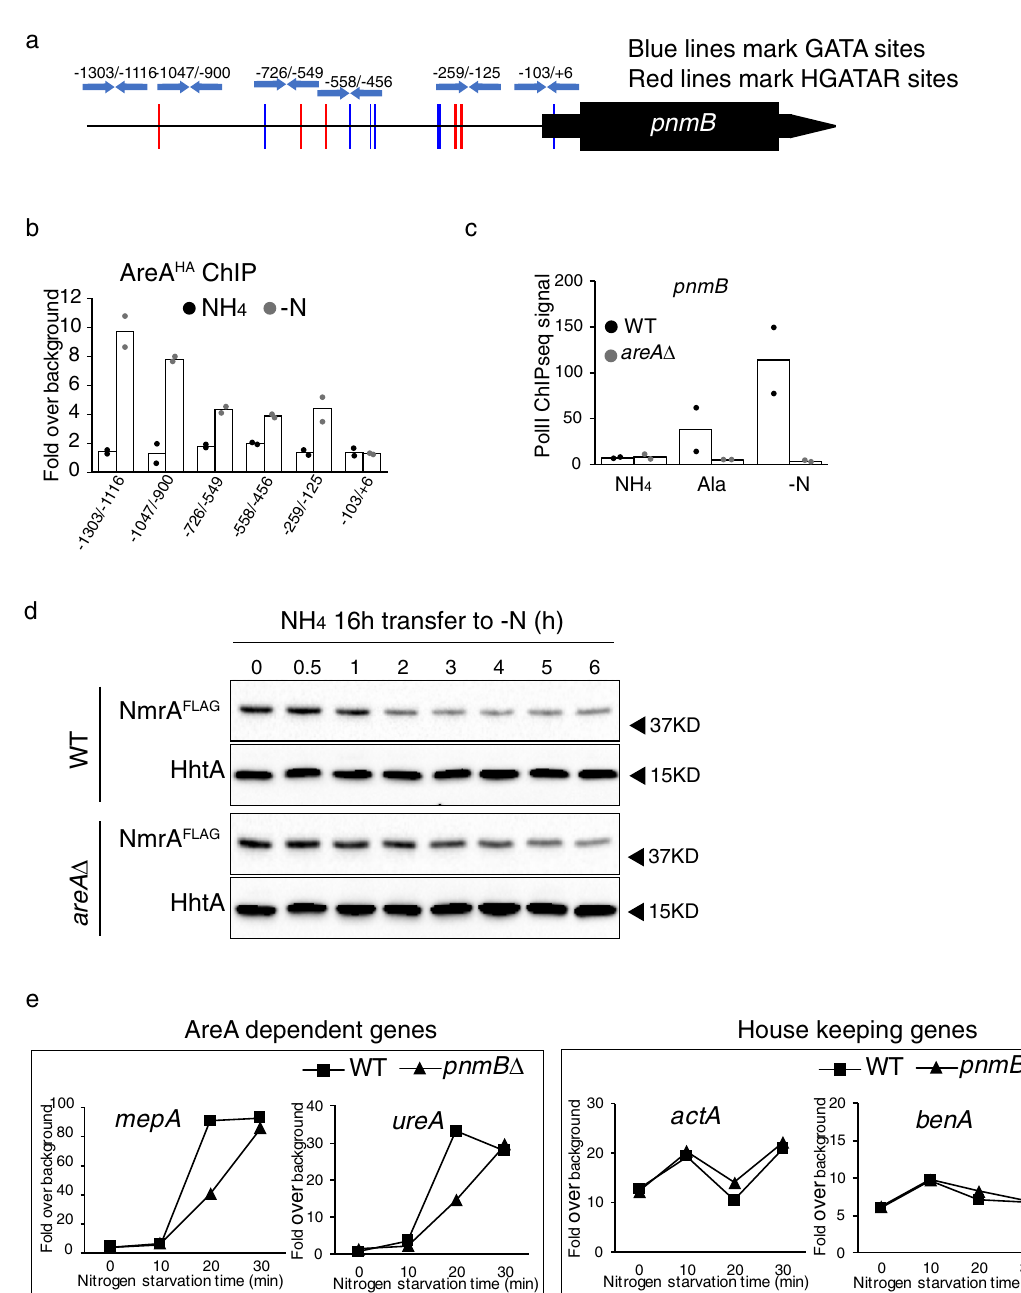
Fig. 2 AreA directly binds to the pnmB promoter and activates pnmB expression, leading to downregulation of NmrA levels and, consequently, acceleration of the nitrogen-starvation response. a GATA motif distribution across the pnmB promoter. Locations of the previously published AreA recognition motif HGATAR (red), GATA sequences (blue), and real-time PCR primers used in ChIP analysis (blue arrows) are shown. b ChIP followed by real- time PCR analysis against AreA over different GATA sequences at the pnmB promoter using primers marked in a under nitrogen-suf fi cient (NH 4 ) and -starvation (-N) conditions. Average fold over background from two independent experiments is presented (black dots for NH 4 condition and gray dots for -N condition). c A histogram showing PolII ChIP-seq signal on pnmB coding region in WT (black dots) and areA Δ (gray dots) grown under nitrogen-suf fi cient (NH 4 ), -limiting (Ala), and -starvation (-N) conditions from two independent experiments. d Western blot analysis of NmrA FLAG in wild-type (WT) and areA Δ strains before and after 0.5, 1, 2, 3, 4, 5, and 6h of nitrogen starvation. The histone H3 protein (HhtA) was used as a loading control. e PolII ChIP followed by real-time PCR analysis of AreA-dependent genes ( mepA and ureA ) and housekeeping genes upon nitrogen starvation. PolII binding is expressed as fold over background and a representative of three independent experiments are presented. See Supplementary Fig. 6 for the results of biological PnmB exists as two distinct forms . The intracellular protein compared to wild type (Fig. 2e and Supplementary Fig. 6). Taken together, the above results demonstrate that AreA kick-starts a fraction of the wild-type PnmB HA strain contains two distinct PnmB HA protein bands of similar abundance in western blot regulatory feedback loop to degrade its co-repressor NmrA in analysis (Fig. 1e). The two bands were also observed in the order to stimulate its own activation capacity during the early intracellular fraction of the total protein extract when PnmB HA phase of nitrogen starvation.